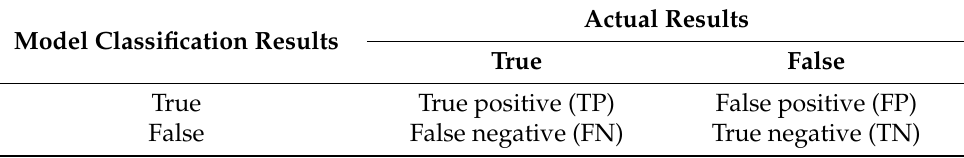
Table 1. Confusion matrix for the diagnostic model